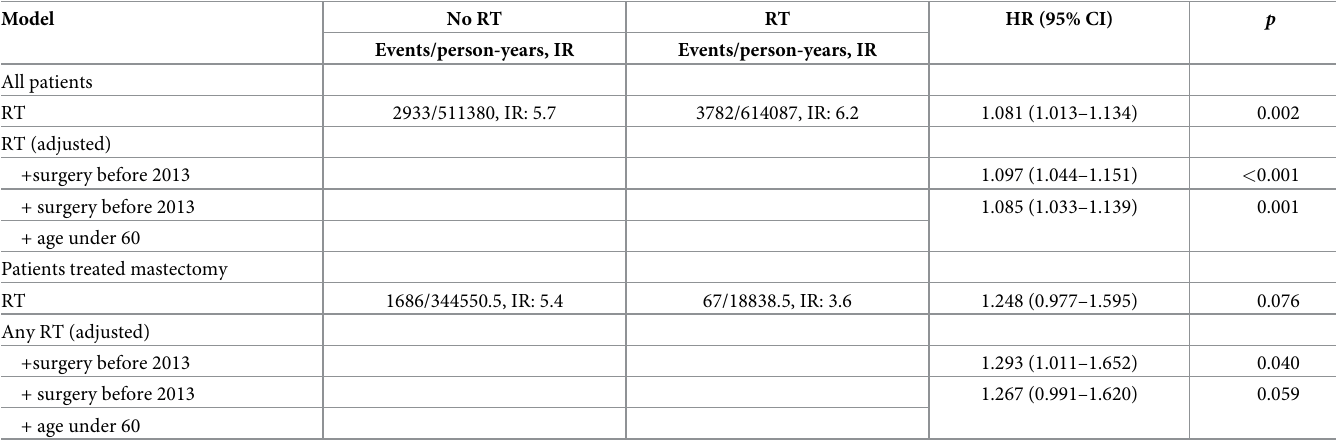
Table 2. Incidence rates, unadjusted and adjusted risk of hypothyroidism associated with RT.